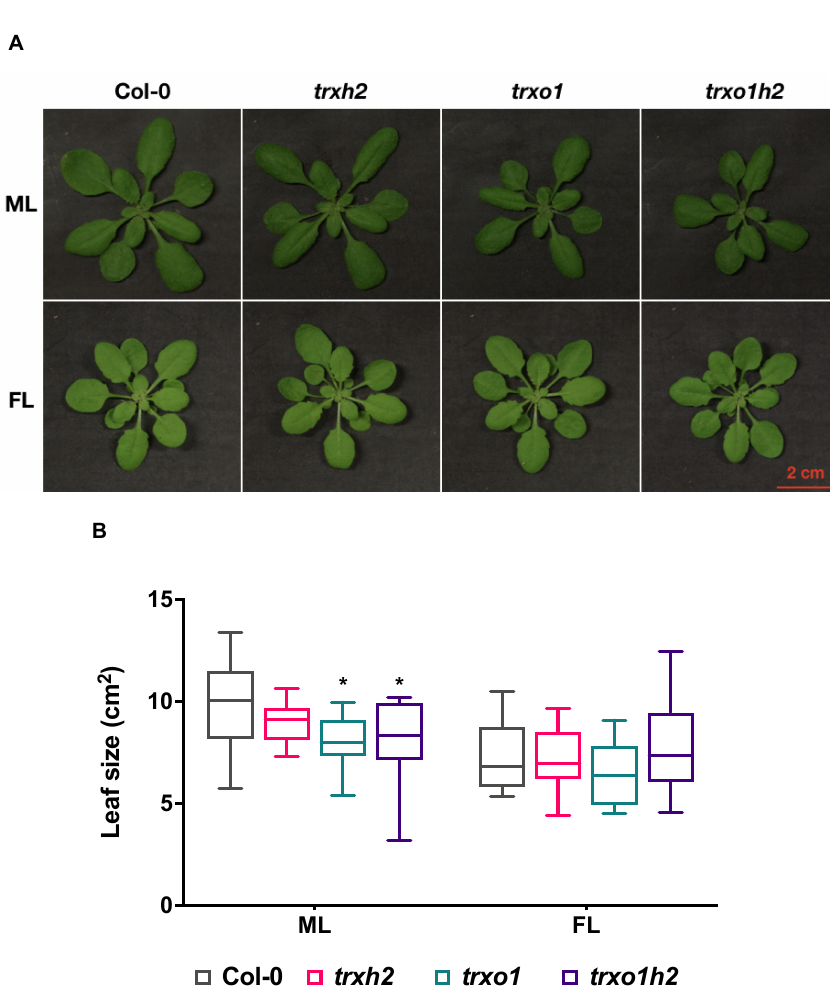
Figure 3. Growth phenotype of the wild type (Col-0) and mutant lines ( trxh2 , trxo1 and trxo1h2 ) grown under medium (ML) or fluctuating (FL) light conditions. ( A ) Visible phenotype of rosette leaves. ( B ) The box plot of leaf size. Mean values derived from 10–14 plants. The statistical analyses were performed by using ANOVA and the Dunnett’s test (* p < 0.05, in comparison to the wild type). Scale bar = 2 cm.